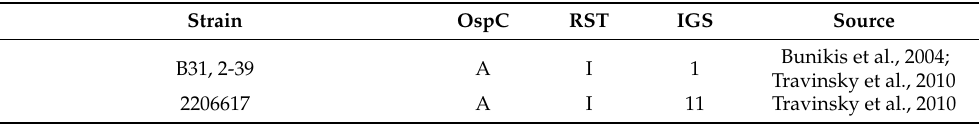
Table 1. Currently known human-infecting Borrelia burgdorferi strains with corresponding typing